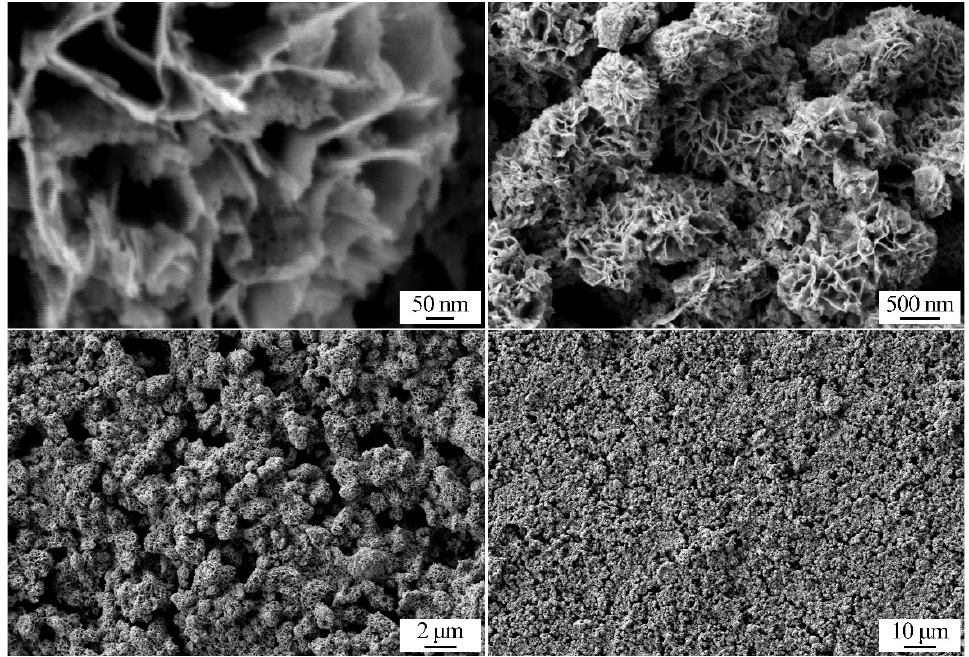
Figure 8. Microstructure of the printed NiCo 2 O 4 film (SEM data).